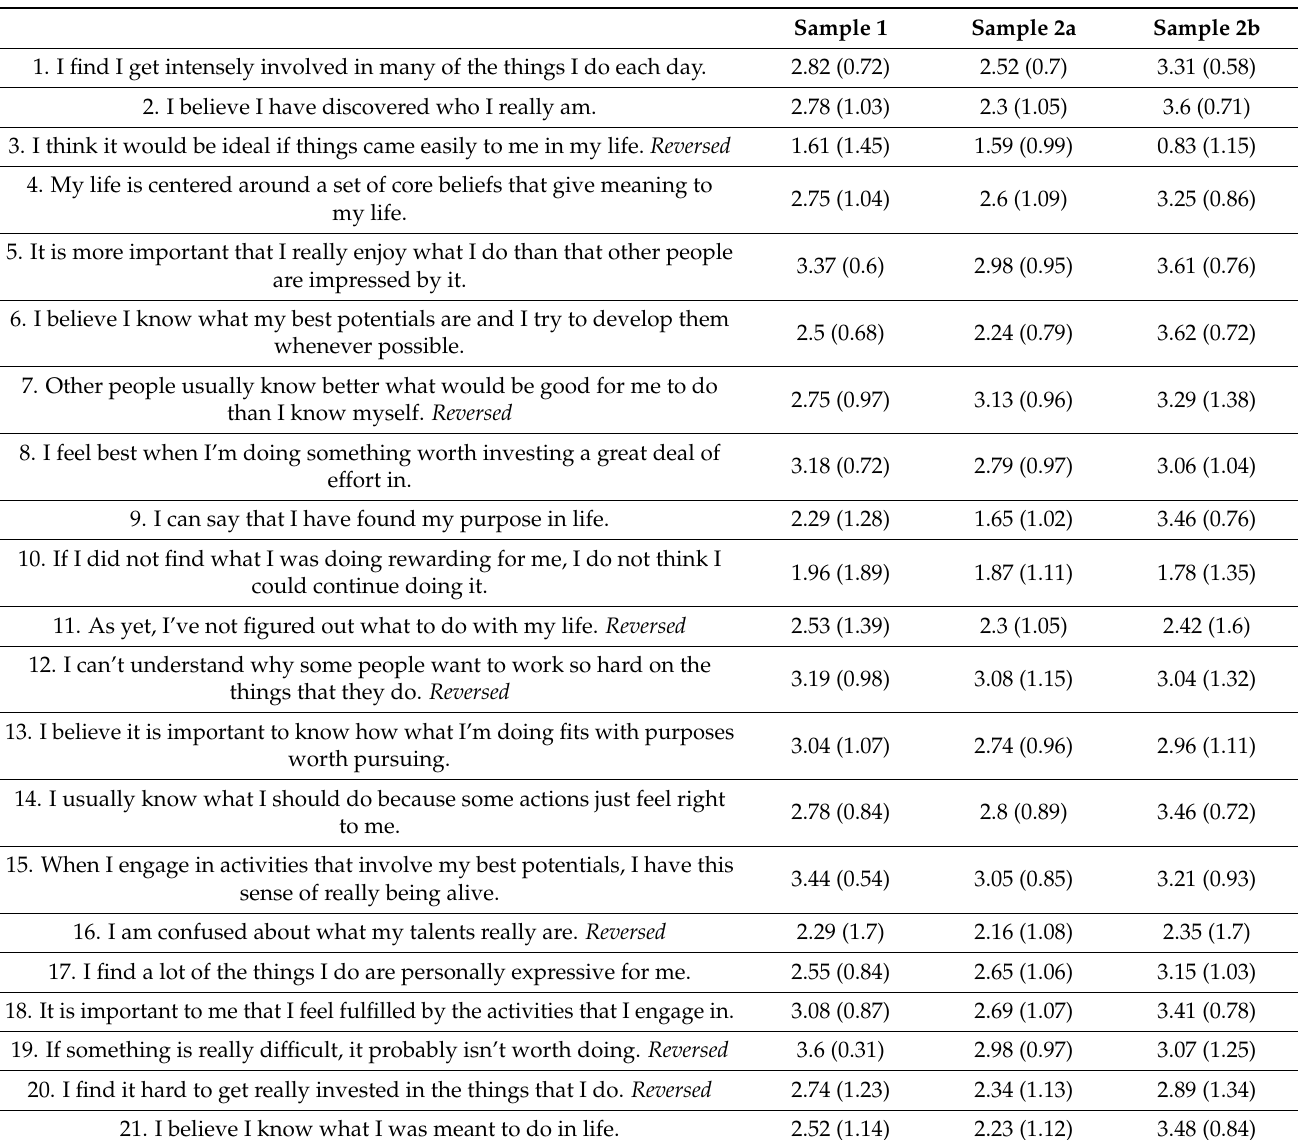
Table 1. Average score for each question of the QEWB [37] by sample. Standard deviation in